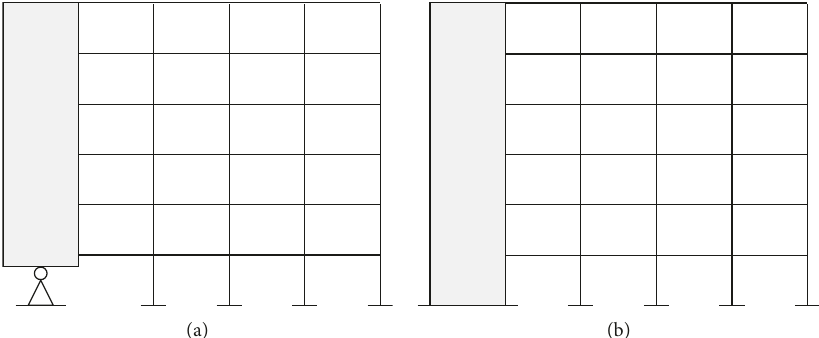
Figure 1: Illustration of two types of FSCW structures. (a) One adopting the rocking wall. (b) One adopting the stepping